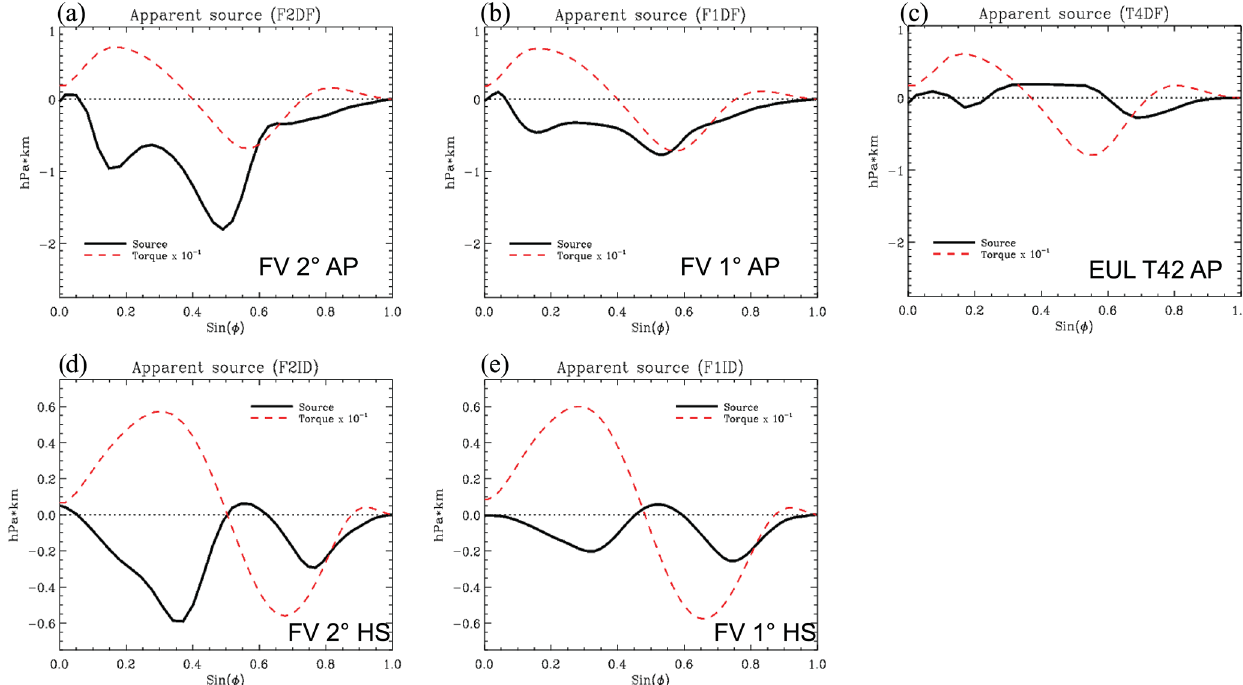
Figure 1. Numerical torque in idealised CAM simulations. The vertically and zonally integrated apparent numerical torque is shown as a function of latitude for CAM simulations in aquaplanet (AP; a , b and c ) and Held–Suarez (HS; d and e ) configurations. The numerical torque here is obtained as a time-average residual of the tendency of angular momentum in each cylindrical shell of constant latitude of the model’s domain, after subtracting the contributions from meridional convergence and from the surface stress torque. The details of the calculation are in Appendix A. Two simulations with the FV dynamical core are shown for each configuration, one at f19 resolution (i.e. on a regular latitude–longitude grid with spacing of 1.9 ◦ × 2.5 ◦ ; a and d ) and one at f09 (i.e. with twice that resolution; b and e ). For comparison, a CAM simulation in AP configuration with the global spectral dynamical core at quadratic triangular truncation T42 (roughly comparable to FV at f19 resolution) is also shown in (c) . The dashed red line in each panel indicates the physical torque from surface stresses scaled by a factor 0.1. Positive values indicate an eastward torque acting on the atmosphere, and negative values indicate a westward torque acting on the